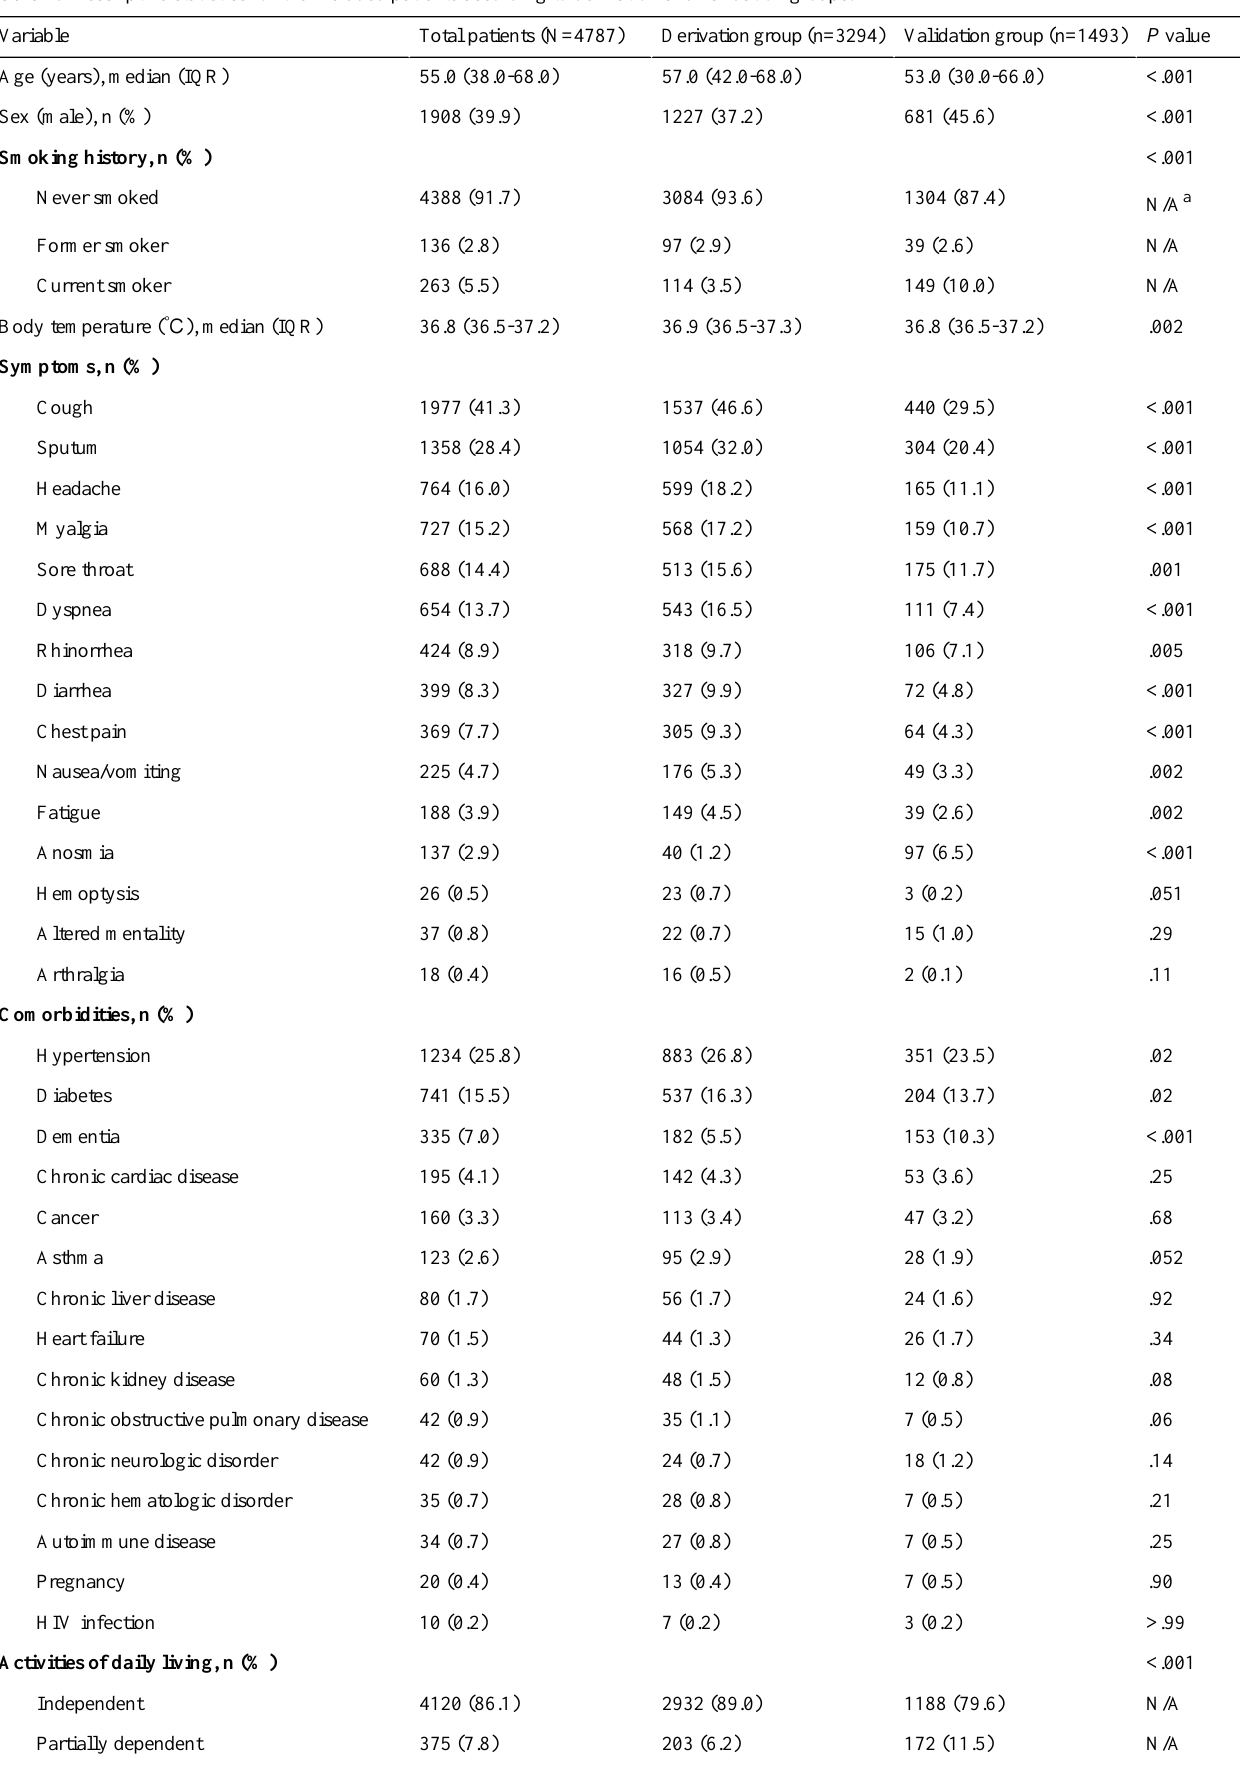
Table 1. Descriptive statistics for the included patients according to derivation and validation